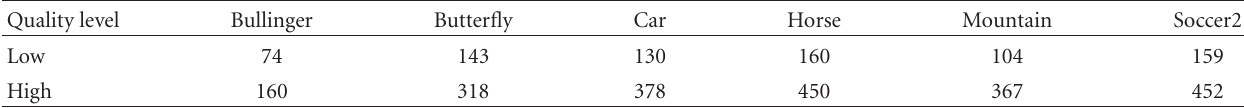
Table 6: Target bit rates of the final test sequences.